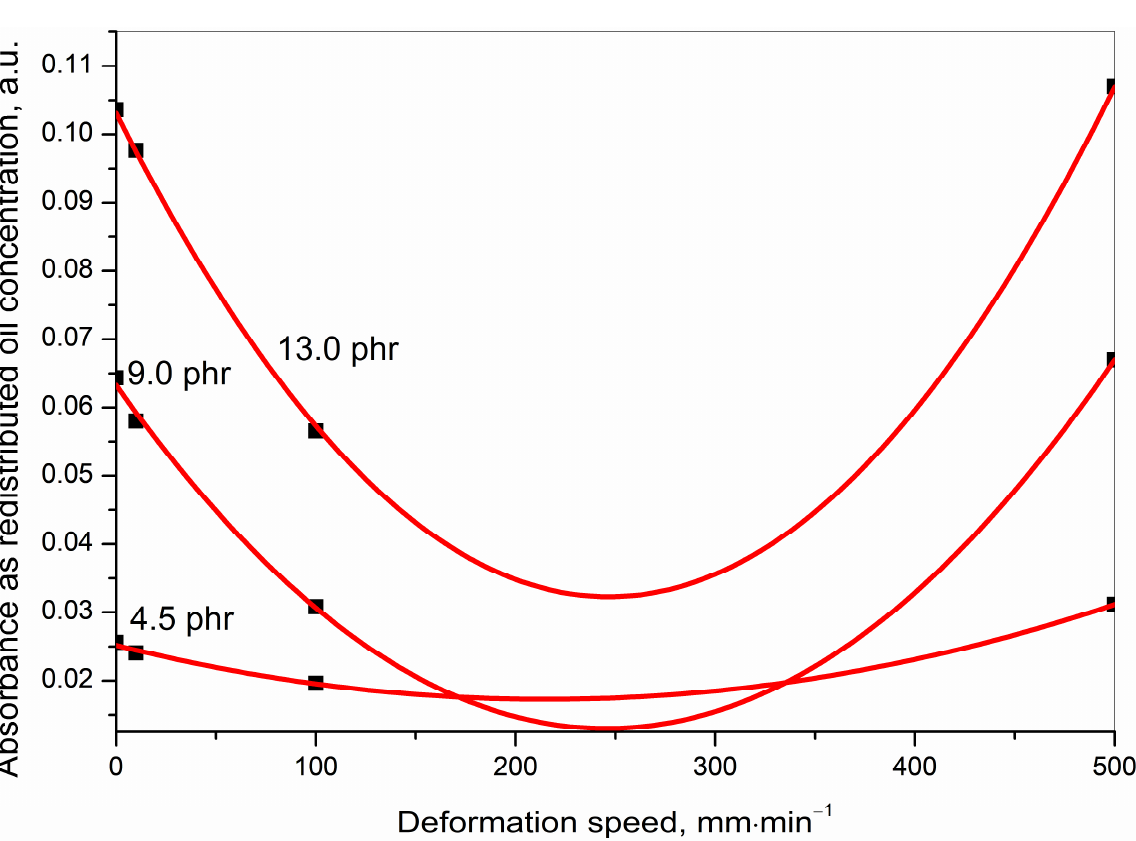
Figure 9. Redistributed oil concentration as a function of deformation speed for various initial oil concentrations.